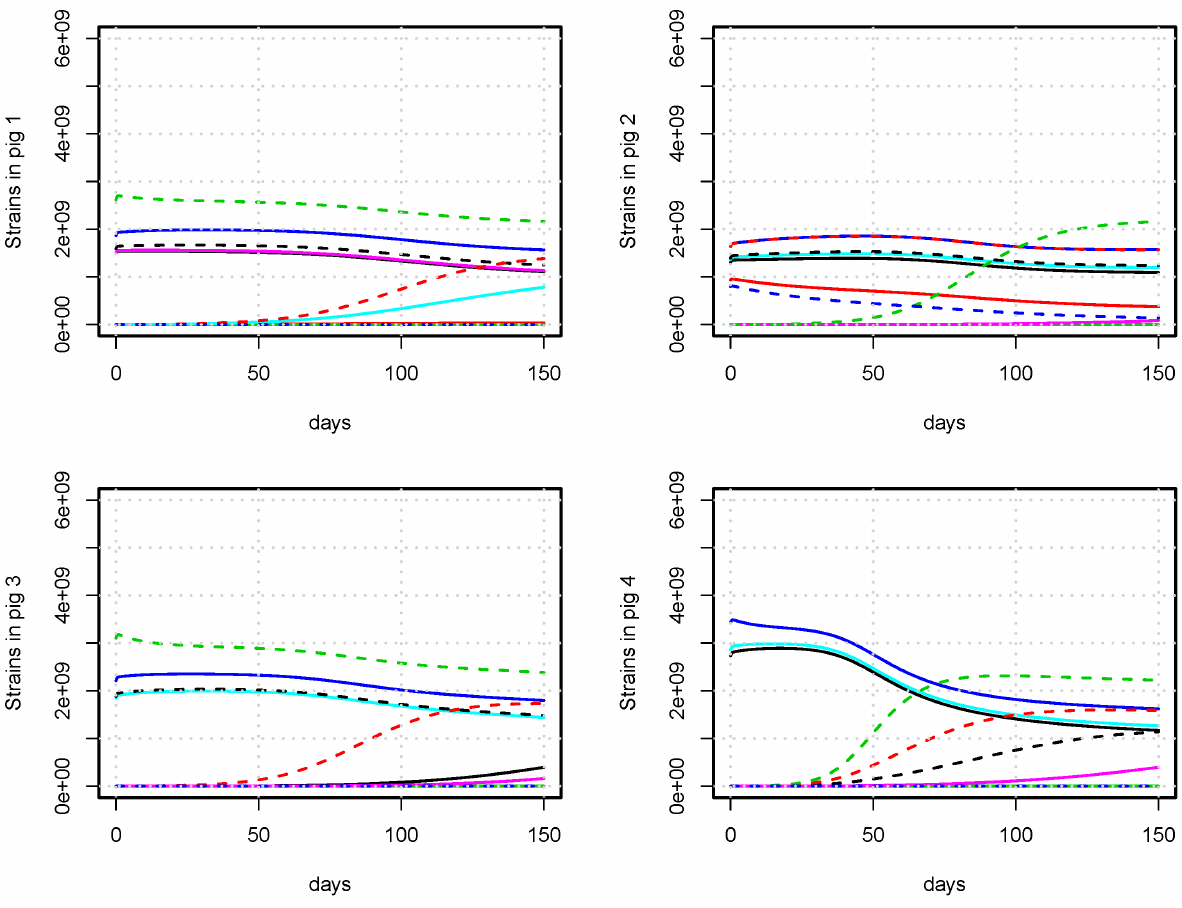
Figure 2. Bacterial composition of the gut of untreated pigs. An example of the bacterial count of strains in four pigs with no AMT. Unique strains are identified by different color. Resistant strains are identified with dashed lines. The bacterial populations are stable on the time-scale of days, and the transmission of strains from other pigs happen over a time-scale of months.